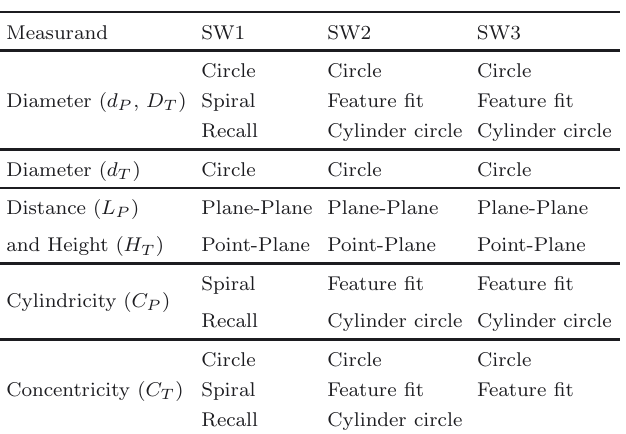
Table 3. An overview of evaluation strategies for selected mea- surands applied in the software packages. Approximately 1000 measured points were used to define a respective geometrical